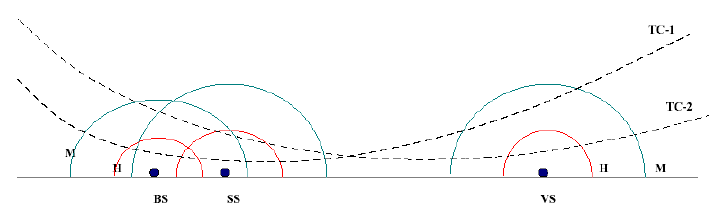
Fig. 5. Schematic illustration of the ground visibilities of the two DSP satellites from the three ground stations. The orbits of TC-1 and TC-2 are plotted with dashed lines. The ground is demonstrated as one black horizontal line, on which the Beijing station (BS), Villafranca station (VS) and Shanghai station (SS) are marked. The boundaries of the ground visibilities at high and mid data dumping rates are shown as red and blue circles,